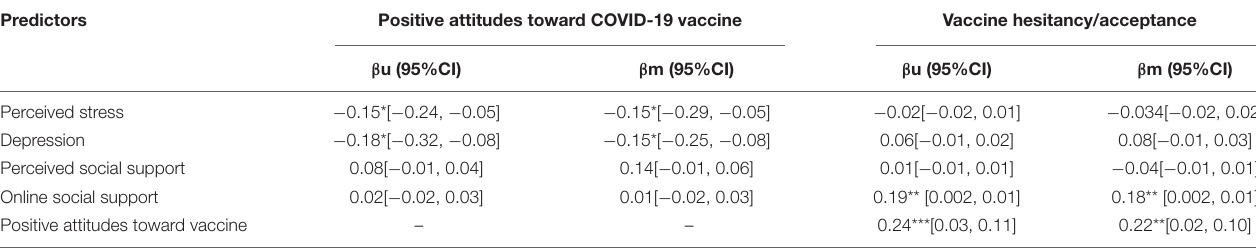
TABLE 3 | Predictors of positive attitudes toward COVID-19 vaccine and vaccine hesitancy/acceptance by multiple linear regression models ( N = 194). Predictors